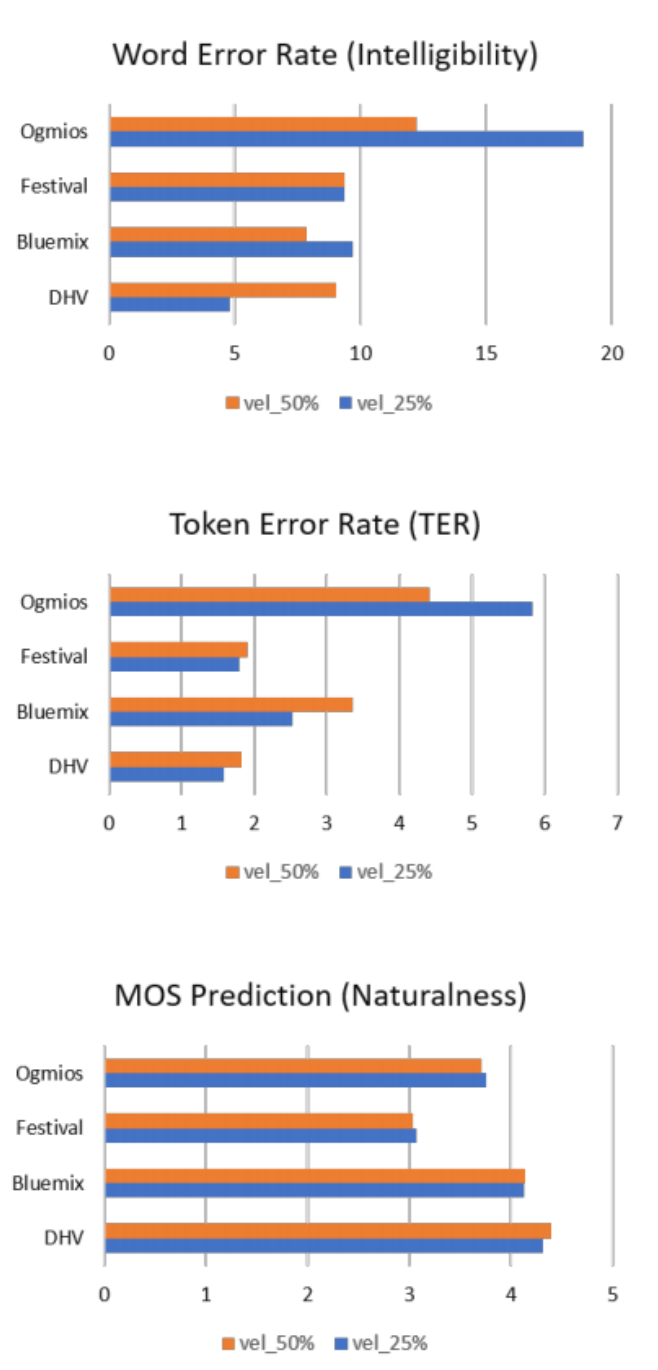
Figure 1. System-level analysis of the WER, TER, and MOS prediction test of the three synthetic voices and the DHV at 25% and 50% slower speech rates.